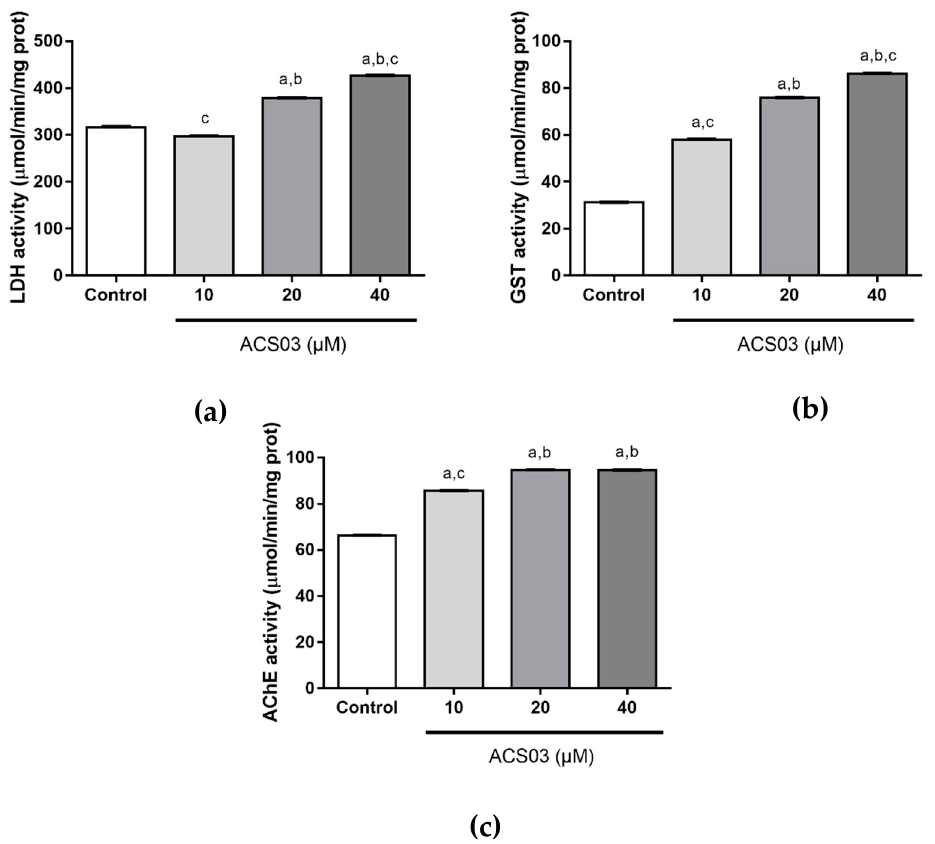
Figure 1. Biomarker activities (mean value ± standard error) in zebrafish larvae after 96 h exposure to different concentrations of ACS03 ( n = 4). ( a ) Lactate dehydrogenase (LDH) activity; ( b ) Glutathione S-transferase (GST) activity; ( c ) Acetylcholinesterase (AChE) activity. a p < 0.05 compared to control group, b p < 0.05 compared to ACS03 10 µM. c p < 0.05 compared to ACS03 20 µM (one-way ANOVA